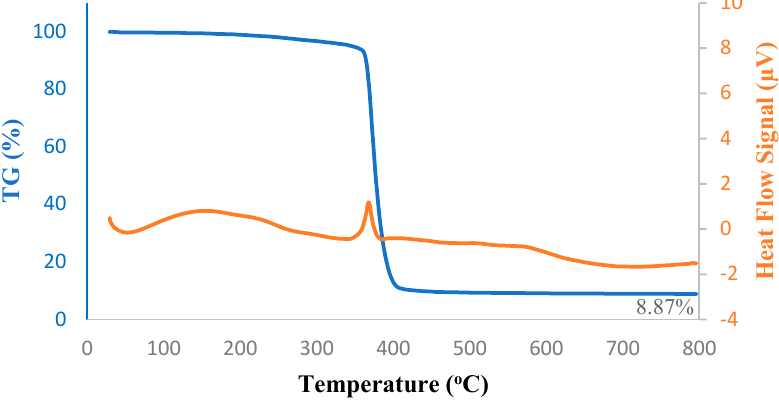
Figure 6. TG-DSC thermograms of PTMSP membrane blended with 5 wt% SNPs.